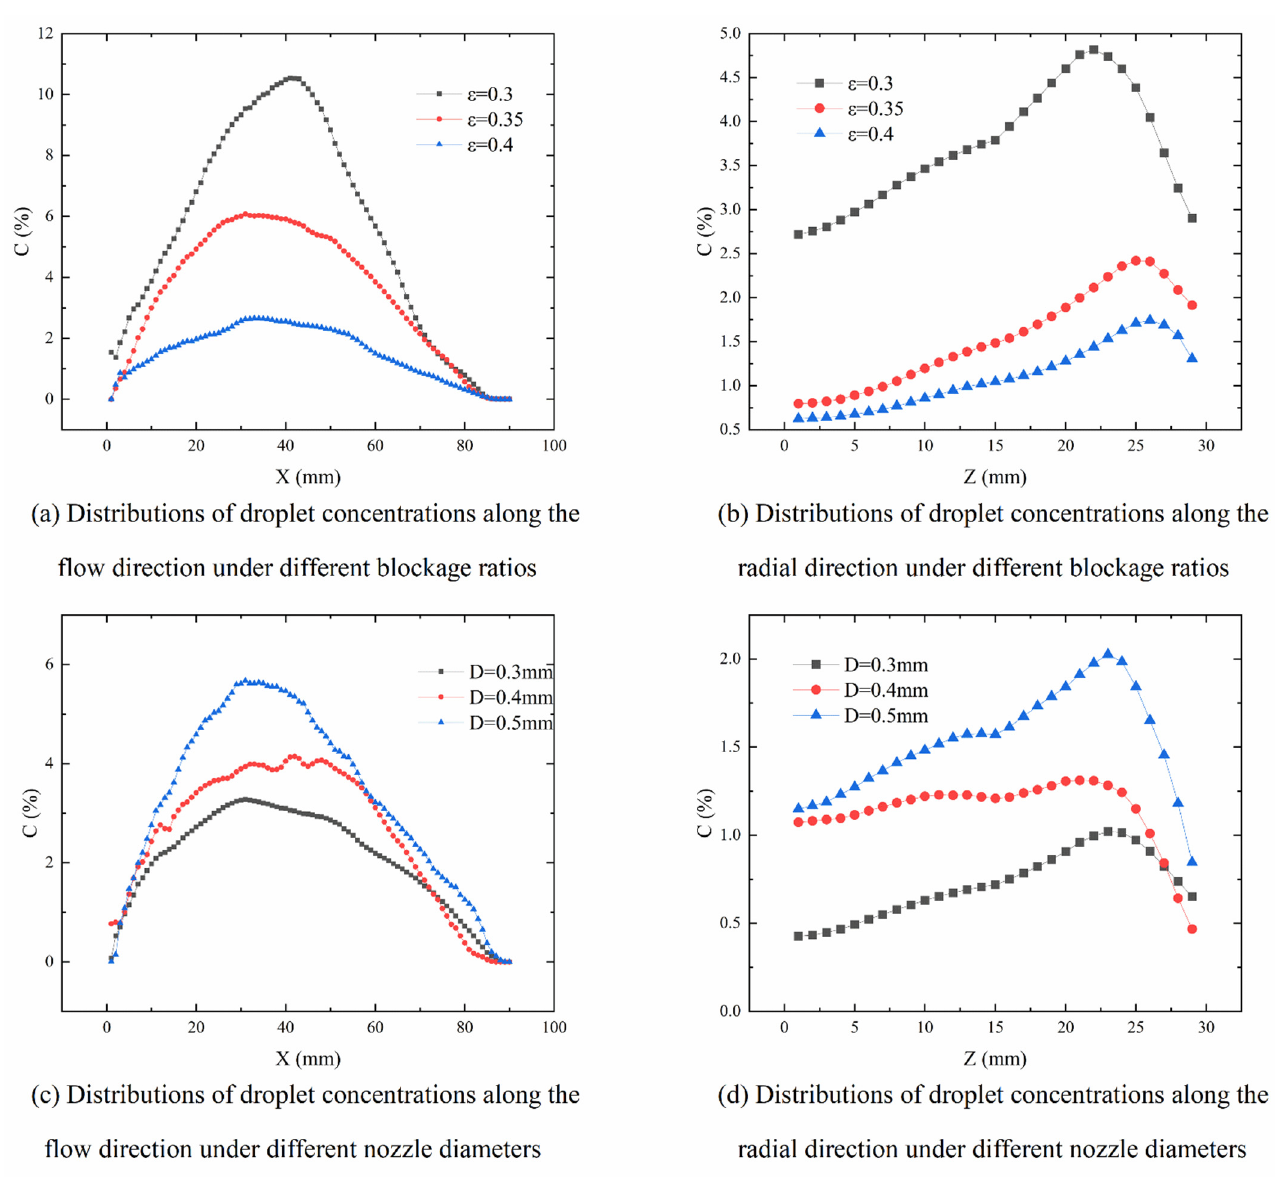
Figure 17. Distributions of droplet concentrations along the flow direction and radial direction. Under a mixing distance of L = 150 mm, blockage ratio of ε = 0.3, and spanwise dis- tance of y = 0 mm, three groups of nozzle diameters were changed to obtain the